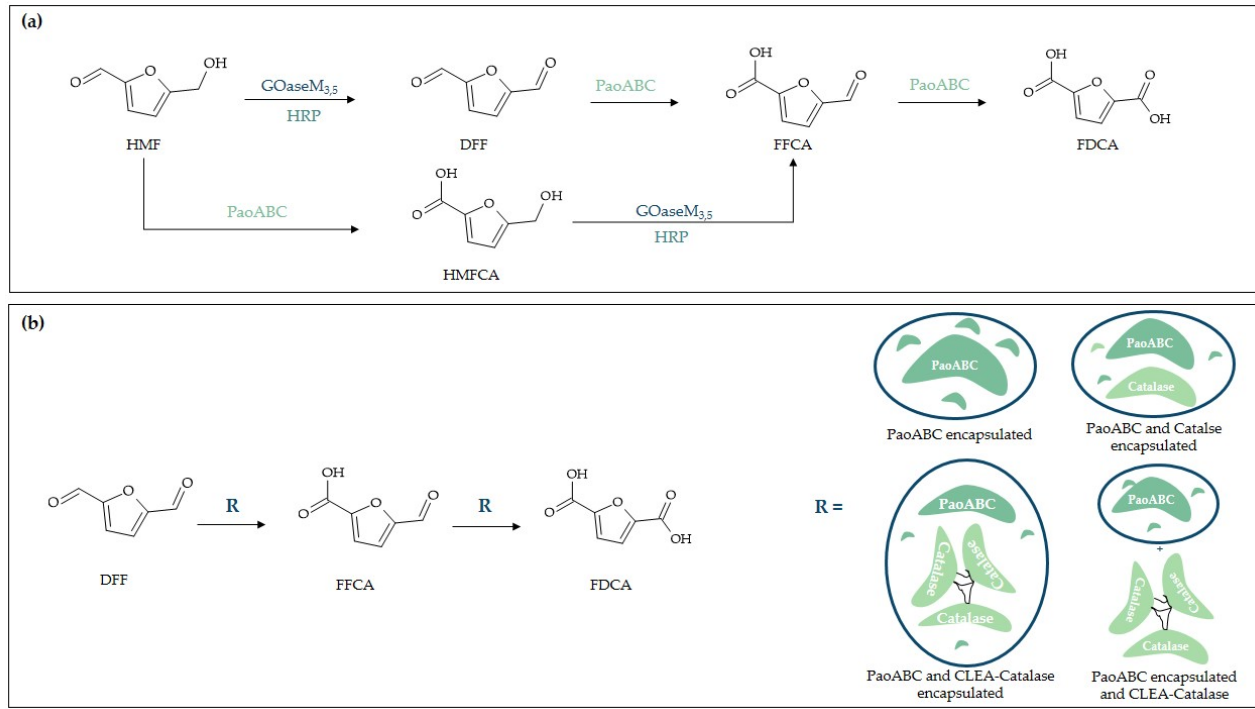
Figure 4. ( a ) One-Pot continuous (GOaseM3,5, HRP, PaoABC and catalase—non-immobilized enzymes) and ( b ) DFF oxidation to FDCA (PaoABC and catalase immobilized). DFF = 2,5-diformylfuran, FDAC = 2,5-furandicarboxylic acid, HMF = 5-hydroxymethylfurfural.